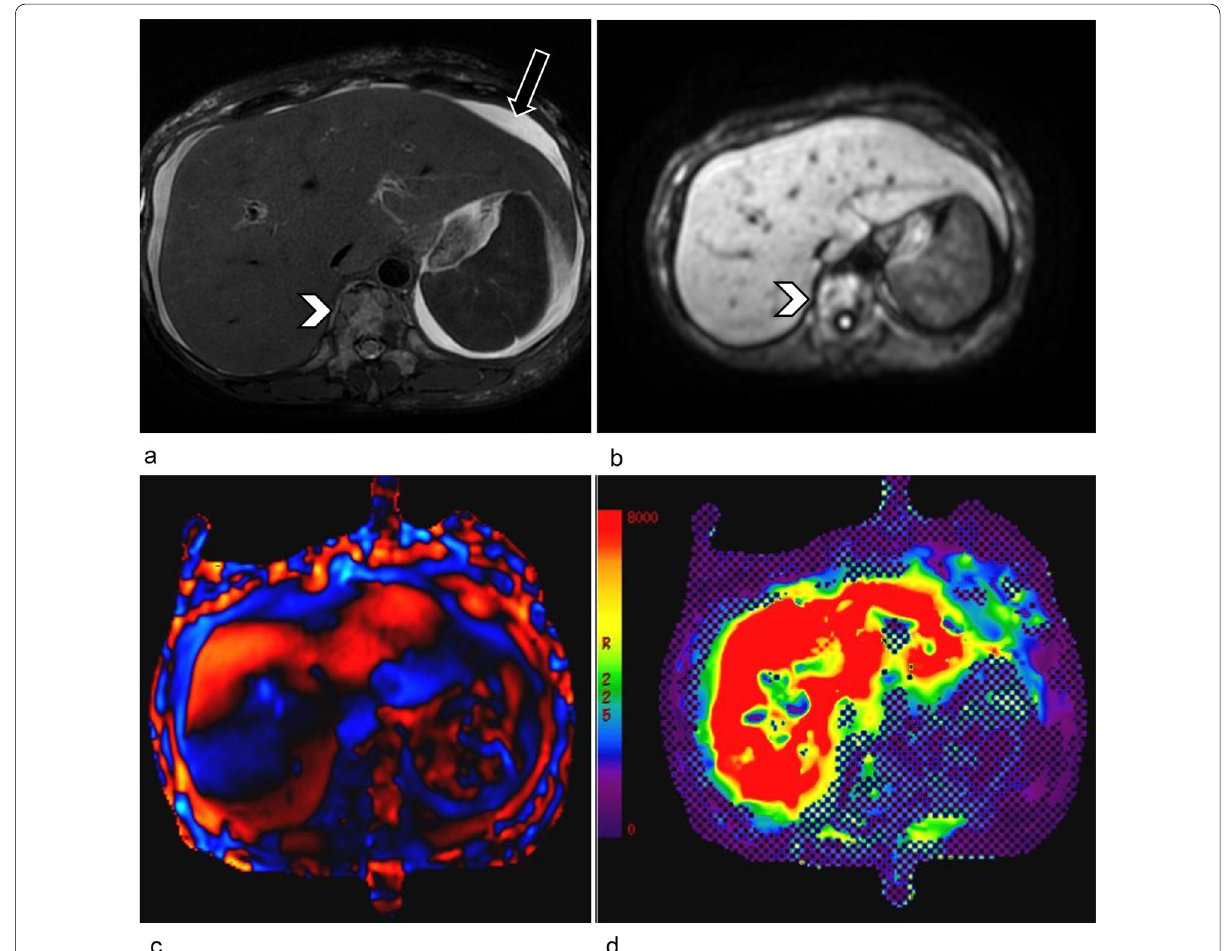
Fig. 4 Metastatic ILC of the liver mimicking hepatic fibrosis in a 55-year-old female who presented with jaundice. She had a remote history of Stage 3C ILC more than 10 years ago. a Axial, fat-saturated, T2-weighted MR image and b diffusion-weighted image (b any discrete hepatic lesion. The hepatic outline is smooth, with no morphological features of cirrhosis. Ascites is present (arrow). Bone metastases are also noted (arrowheads). c Wave images from the MR elastography acquisition at 60 Hz show shear waves with prolonged wavelength. d MR elastogram demonstrates severely increased mean shear stiffness in the liver, with corresponding quantitative color scale on the left of the image. Mean stiffness value is 15.6 kPa (normal < 2.93 kPa), in keeping with F4 fibrosis. The diagnosis of infiltrative metastatic ILC was confirmed